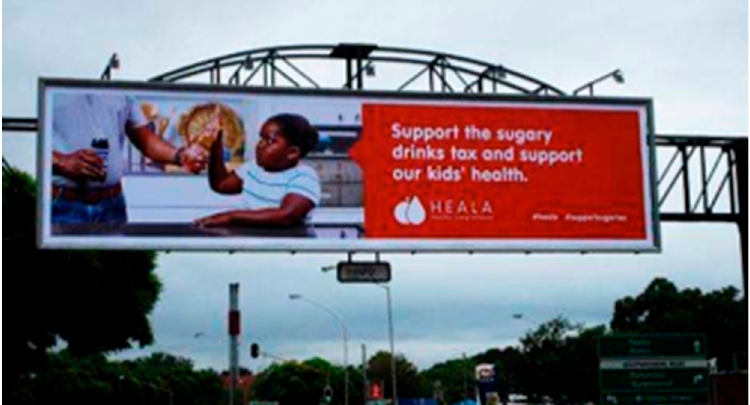
Figure 3. Photograph of outdoor media (billboard) from the campaign, “Support the sugary drinks tax and support our kids’ health!”